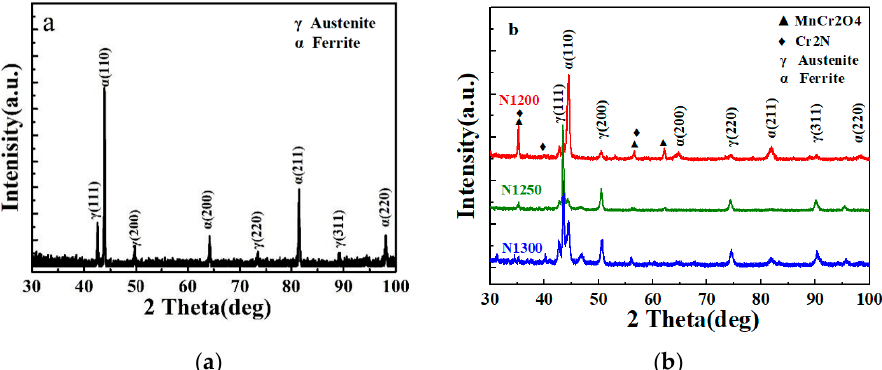
Figure 2. XRD patterns of ( a ) as-received powders; ( b ) porous HNASS samples of N1200, N1250 and N1300.